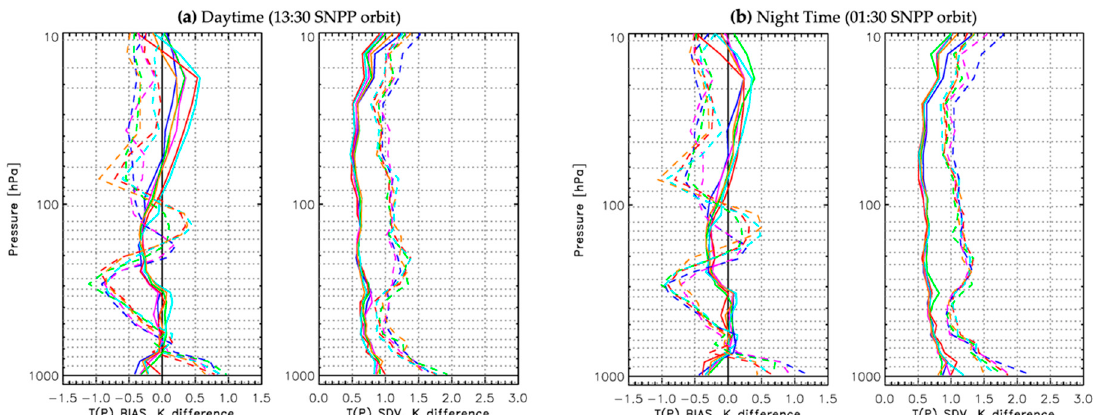
Figure 9. NUCAPS (dashed lines) versus CLIMCAPS (solid lines) for ( a ) daytime and ( b ) night time retrievals from SNPP/CrIS. Sensitivity to choice of a priori estimate for profiles of temperature, T(P) as quantified by the bias and standard deviation (SDV) in units Kelvin for six global days of measurements from SNPP/CrIS retrievals. ECMWF is used as estimate of the true state and space-time interpolated to SNPP/CrIS resolution. Daytime is defined as the ascending SNPP orbit with 13:30 local overpass time and nighttime is the descending SNPP orbit with 01:30 local overpass time.